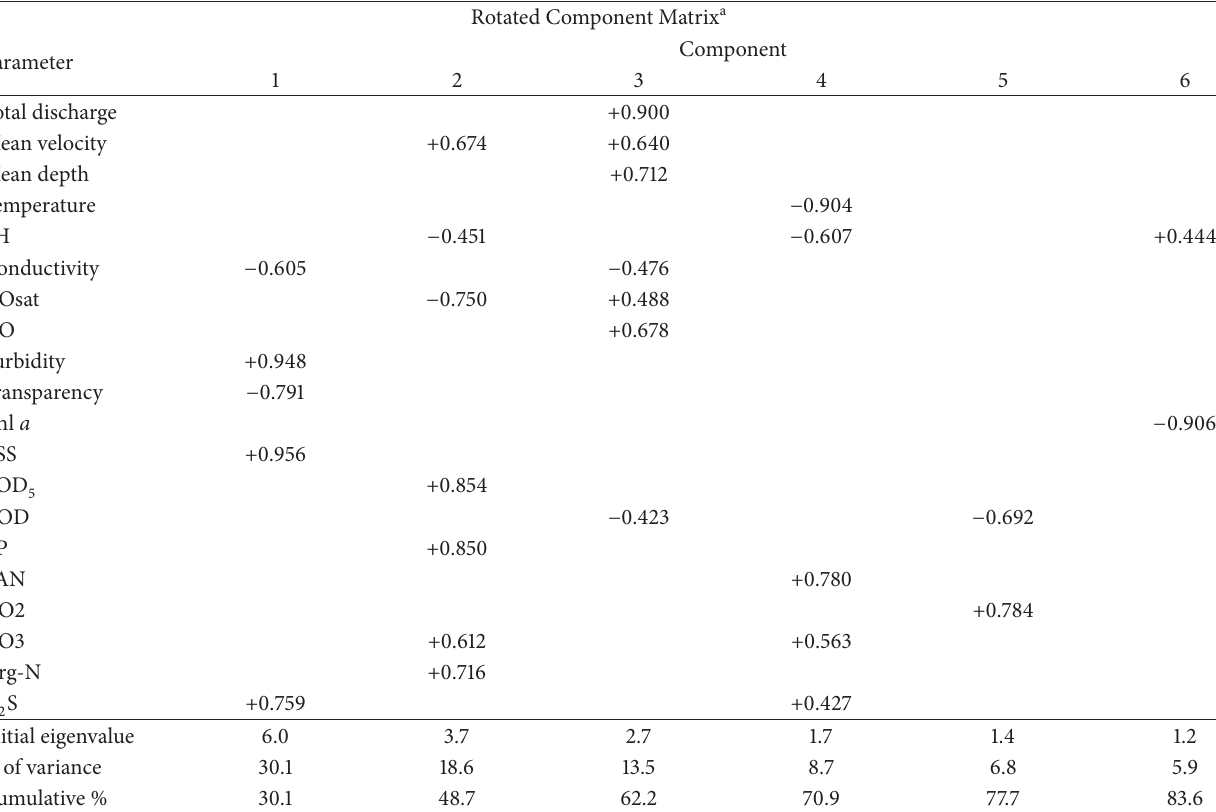
Table 5: Loadings of the physicochemical parameters on the first six varimax-rotated PCs (eigenvalue > 1) along the Batang Baram and its